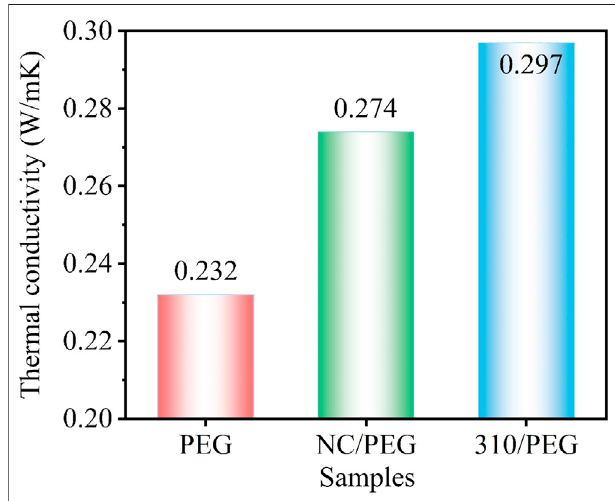
FIGURE 6 | Thermal conductivity of the PEG, the NC/PEG, and the 310/PEG.